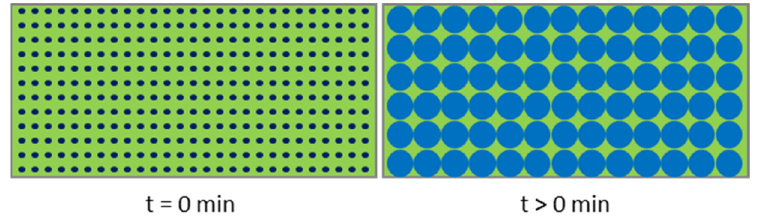
Figure 9. Schematic representation of the diffusion processes in the focal volume. At the start of the measurement, t = 0 min, smaller water droplets with a high solvate concentration (dark blue) are present. As the measurement time progresses, t > 0 min, water diffuses from the outer phase into the inner droplets. This causes the droplets to swell and the solvate concentration to decrease (light blue).